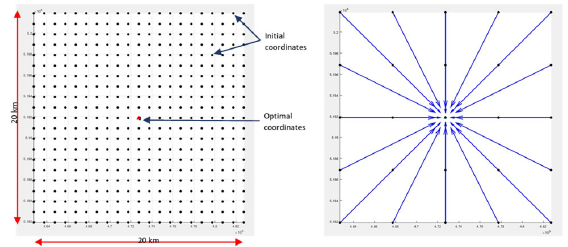
Figure 14. Robust convergence of the proposed method toward optimal value at the